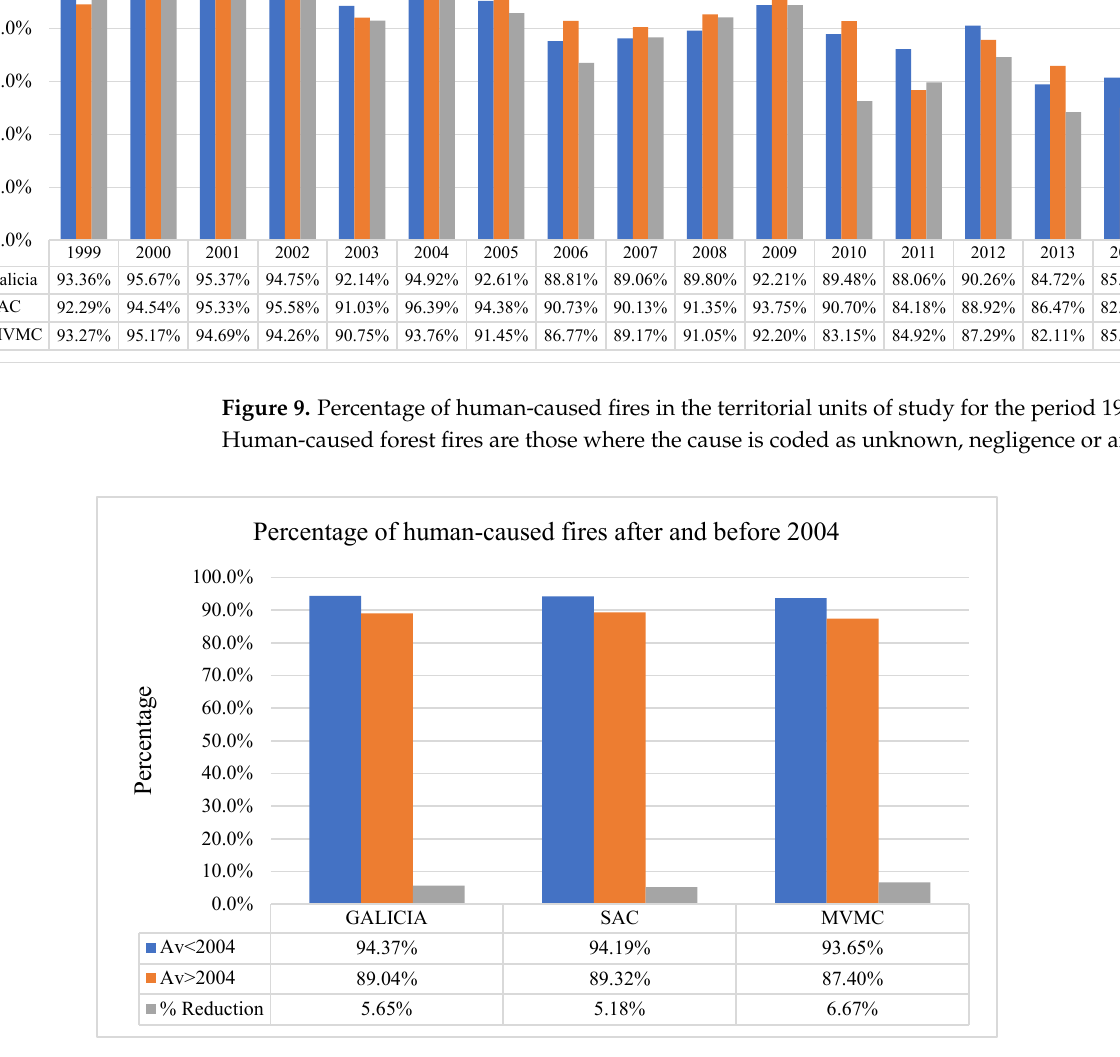
1999–2014. Shown are the mean value of human-caused fires before (blue colour) and after 2004 (ochre colour), and the percentage reduction that occurred after 2004. As can be seen, the highest